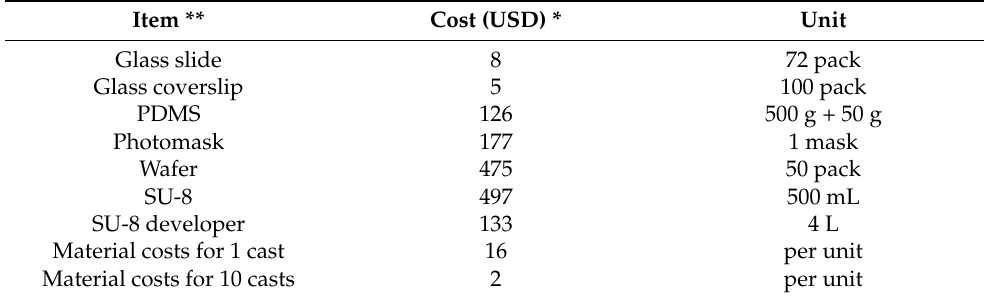
Table 1. Per-unit cost analysis for the SSCC device. Supplies were calculated based on material needed to produce one master wafer and casting of a single SSCC device or a batch of 12 devices. Item ** Cost (USD)